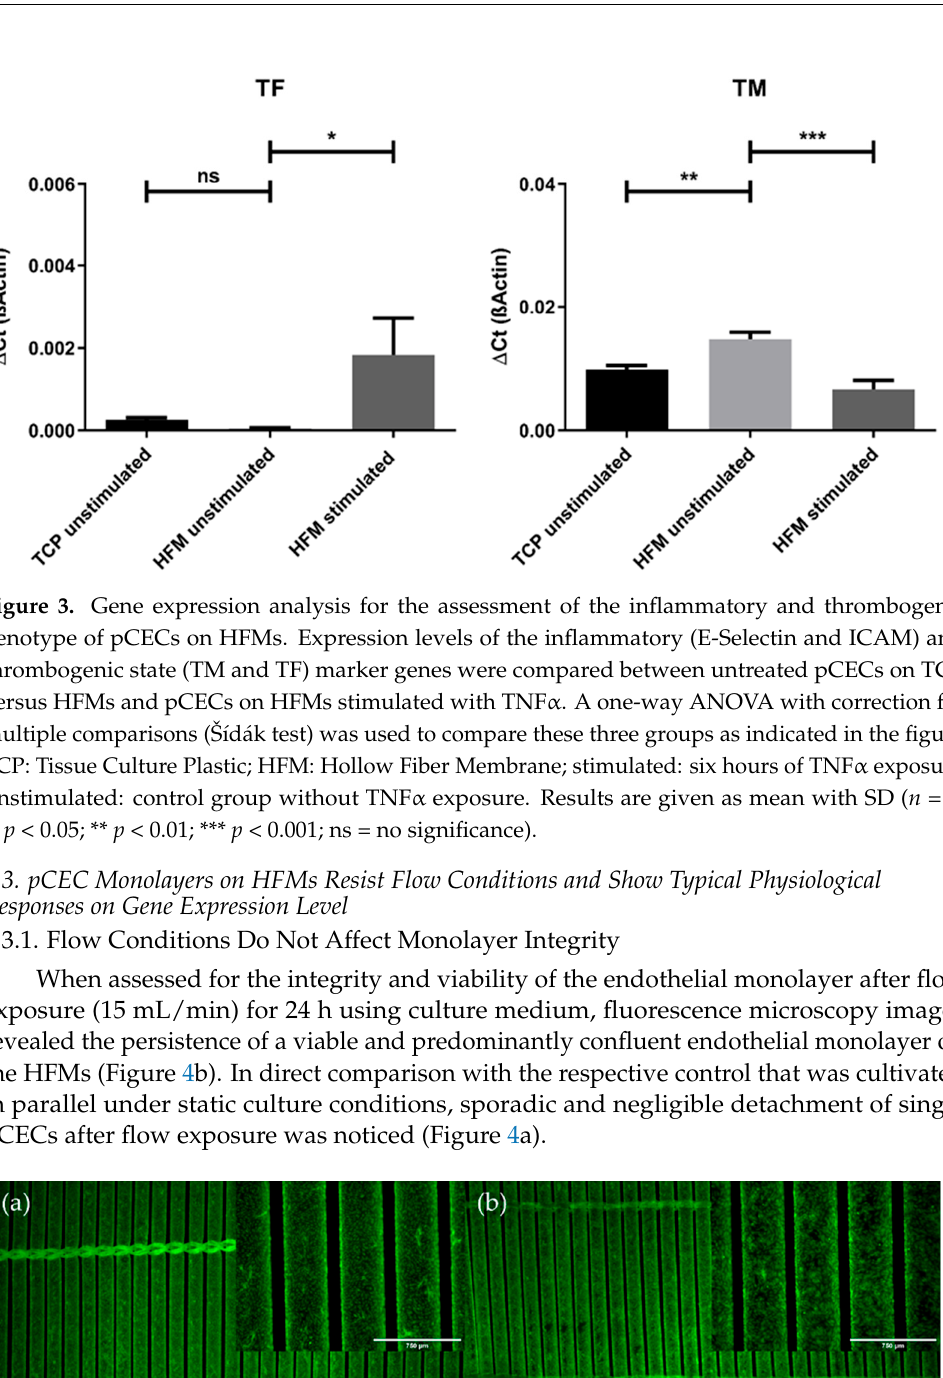
Figure 4. Comparison of pCECs under static and flow conditions. ( a , b ) Calcein staining of viable pCECs (green) after 24 h of static ( a ) or dynamic (15 mL/min flow) ( b ) conditions; ( c ) qRT-PCR analysis of flow-exposed pCECs regarding inflammatory activation (E-Selectin and ICAM), shear stress response (KLF 2), thrombogenic state (TM and TF) and matrix synthesis (Col 4 A1). Gene expression levels of the flow-exposed group were compared to the static control groups using an unpaired t -test. For abbreviations of gene names, see Table 2. Results are given as mean with SD ( n = 3) (* p < 0.05; ** p < 0.01; ns = no significance). 3.3.2. Flow Conditions Lead to Physiological Gene Expression Changes While Not Promoting the Pro-Inflammatory Genotype The impact of flow conditions on pCECs was also examined on gene expression levels (Figure 4c). When compared to static controls, the analyzed genes, indicative for the